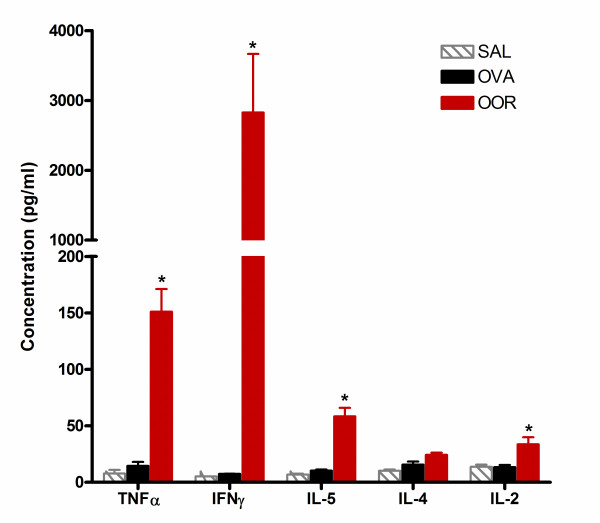
Th1 and Th2 cytokine levels are elevated in the lungs of OOR mice. CBA analysis was used to determine the concentration of TNF-α, IFN-γ, IL-5, IL-4, and IL-2 in whole lung homogenates (n = 3 mice per group; *p < 0.01) isolated on protocol day 30. Data are expressed as means ± SEM.